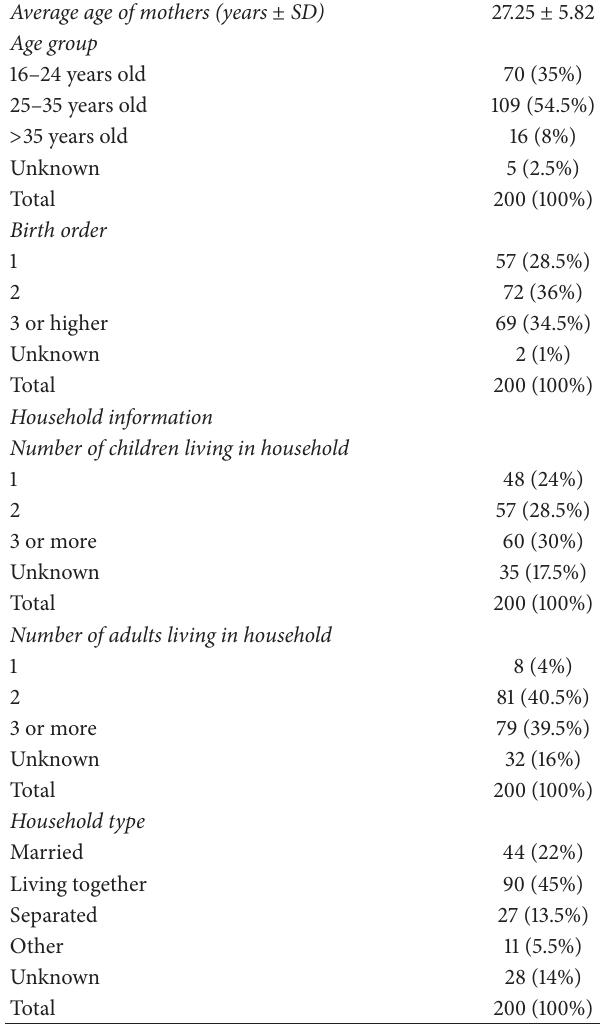
Table 1: Demographics of